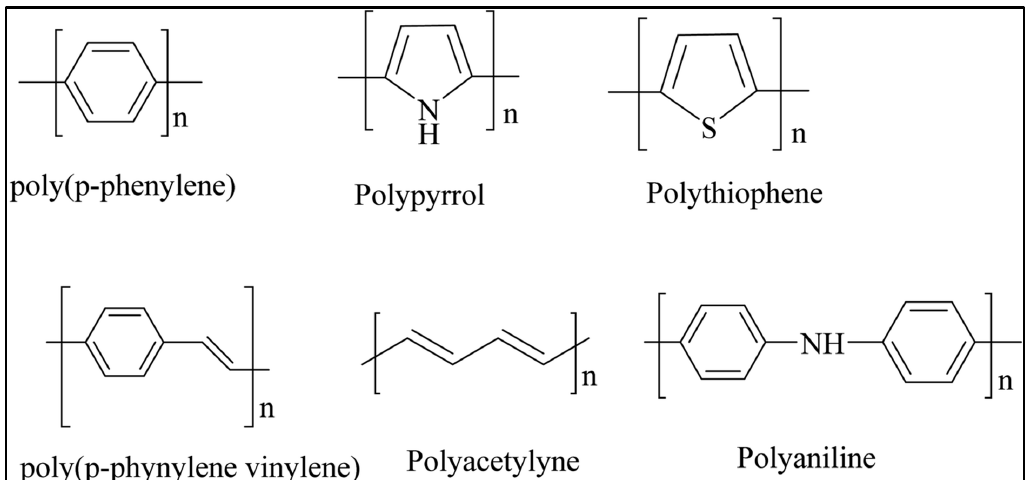
Figure 4. Most utilized conducting polymers. Reprinted with permission reference [49]. Copyright 2021 Royal Society of Chemistry.